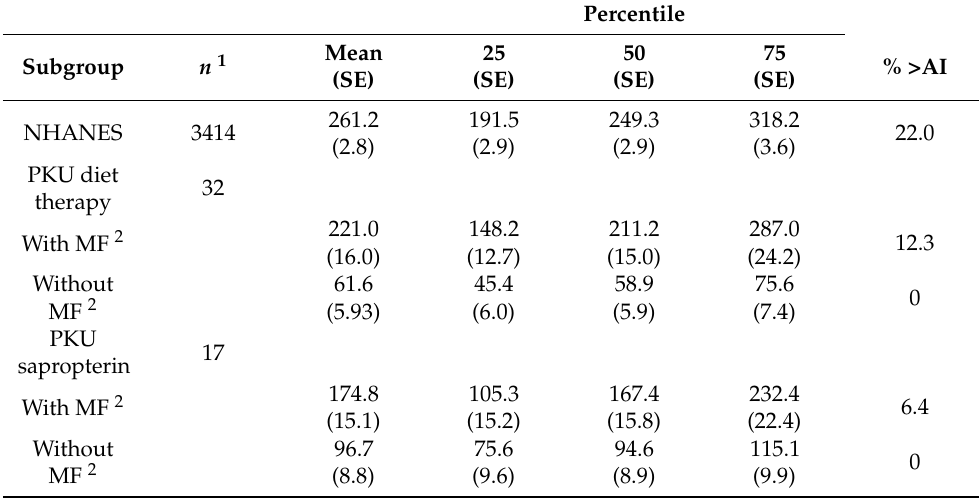
Table 3. Total Usual Intakes and the Estimated Percent (%) of Usual Intakes Above the Adequate Intake (AI) for Choline Among Children 4–17 Years of Age with PKU ( n = 49) and Children from NHANES 2015–2018 ( n =